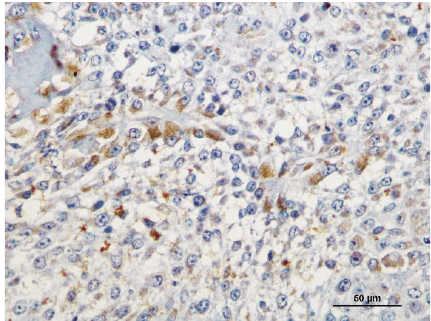
Figure 2: Immunoreactivity for c-kit in carcinosarcoma; bar = 50 𝜇 m.